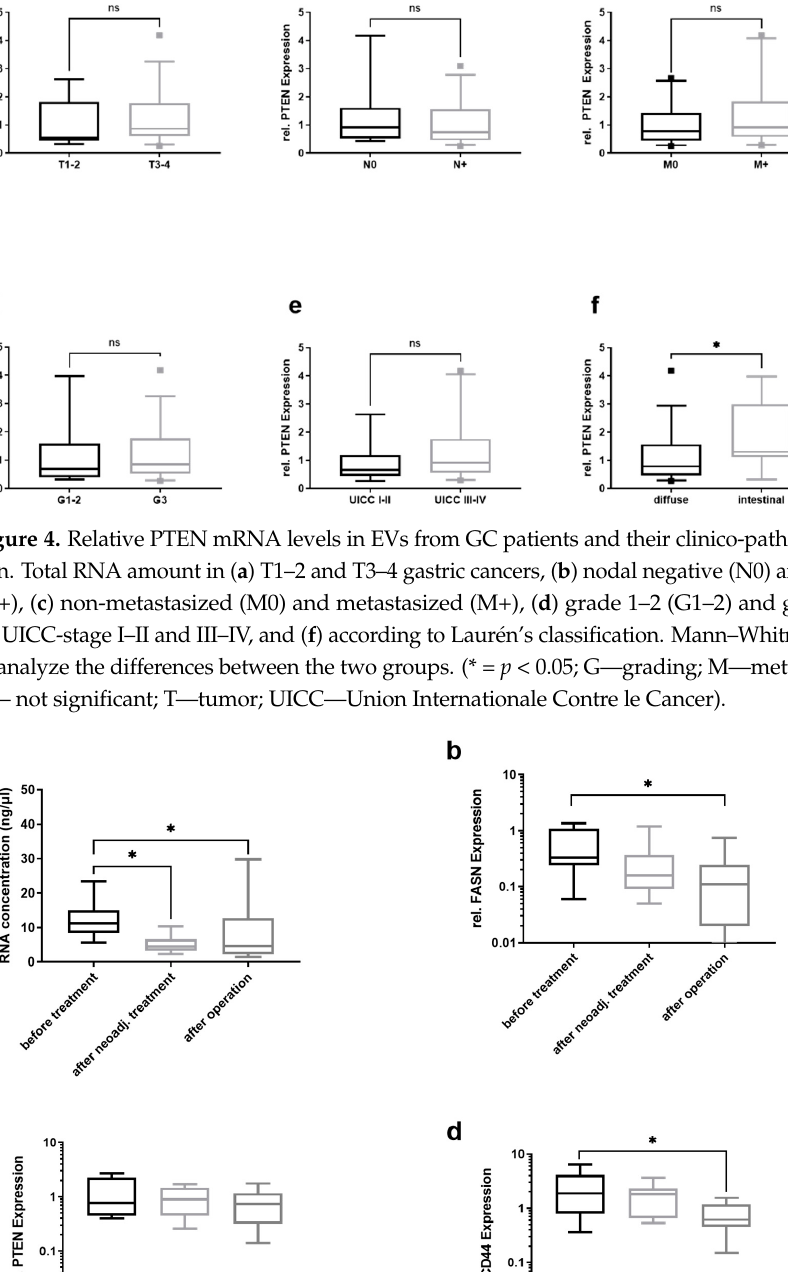
Figure 3. Relative FASN mRNA levels in EVs from GC patients and their clinico-pathological strat- ification. Relative mRNA levels of FASN in ( a ) T1–2 and T3–4 gastric cancers, ( b ) nodal negative (N0), and nodal positive (N+), ( c ) non-metastasized (M0) and metastasized (M+), ( d ) grade 1–2 (G1– 2) and grade 3–4 (G3–4), ( e ) UICC-stage I–II and III–IV, and ( f ) according to Laurén’s classification.